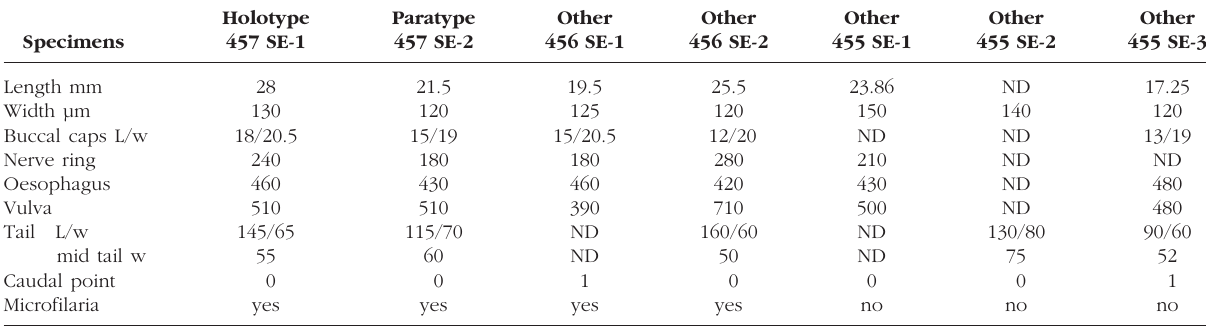
with handle equal to half spicule length, long thin intermediary piece and filamentous lamina (flabellum). Right spicule complex: tubular part with prominent dorsal heel distally; terminal spoon-shaped piece with well-sclerotized lateral edges.